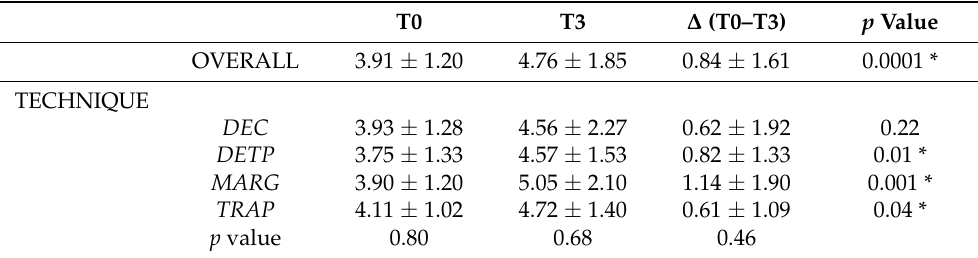
Table 9. Second molar buccal-distal site CAL. Values are presented in mm as mean ( ± standard